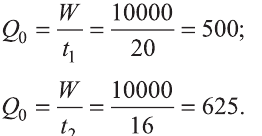
Fig. 2. The concept of isocost lines and the minimal cost of producing Q